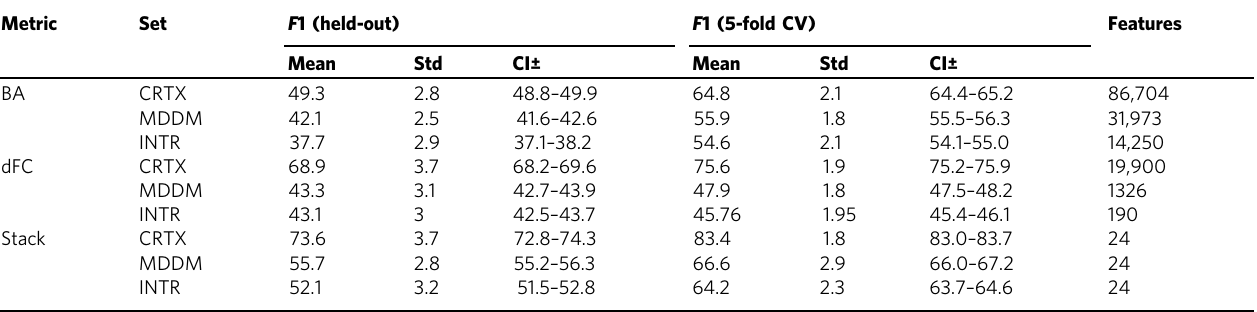
Table 1 Classi fi cation analysis results based on held-out test sample and fi vefold cross-validation (CV). Metric Set F 1 (held-out) F 1 (5-fold CV) Features Mean Std CI± Mean Std CI± BA